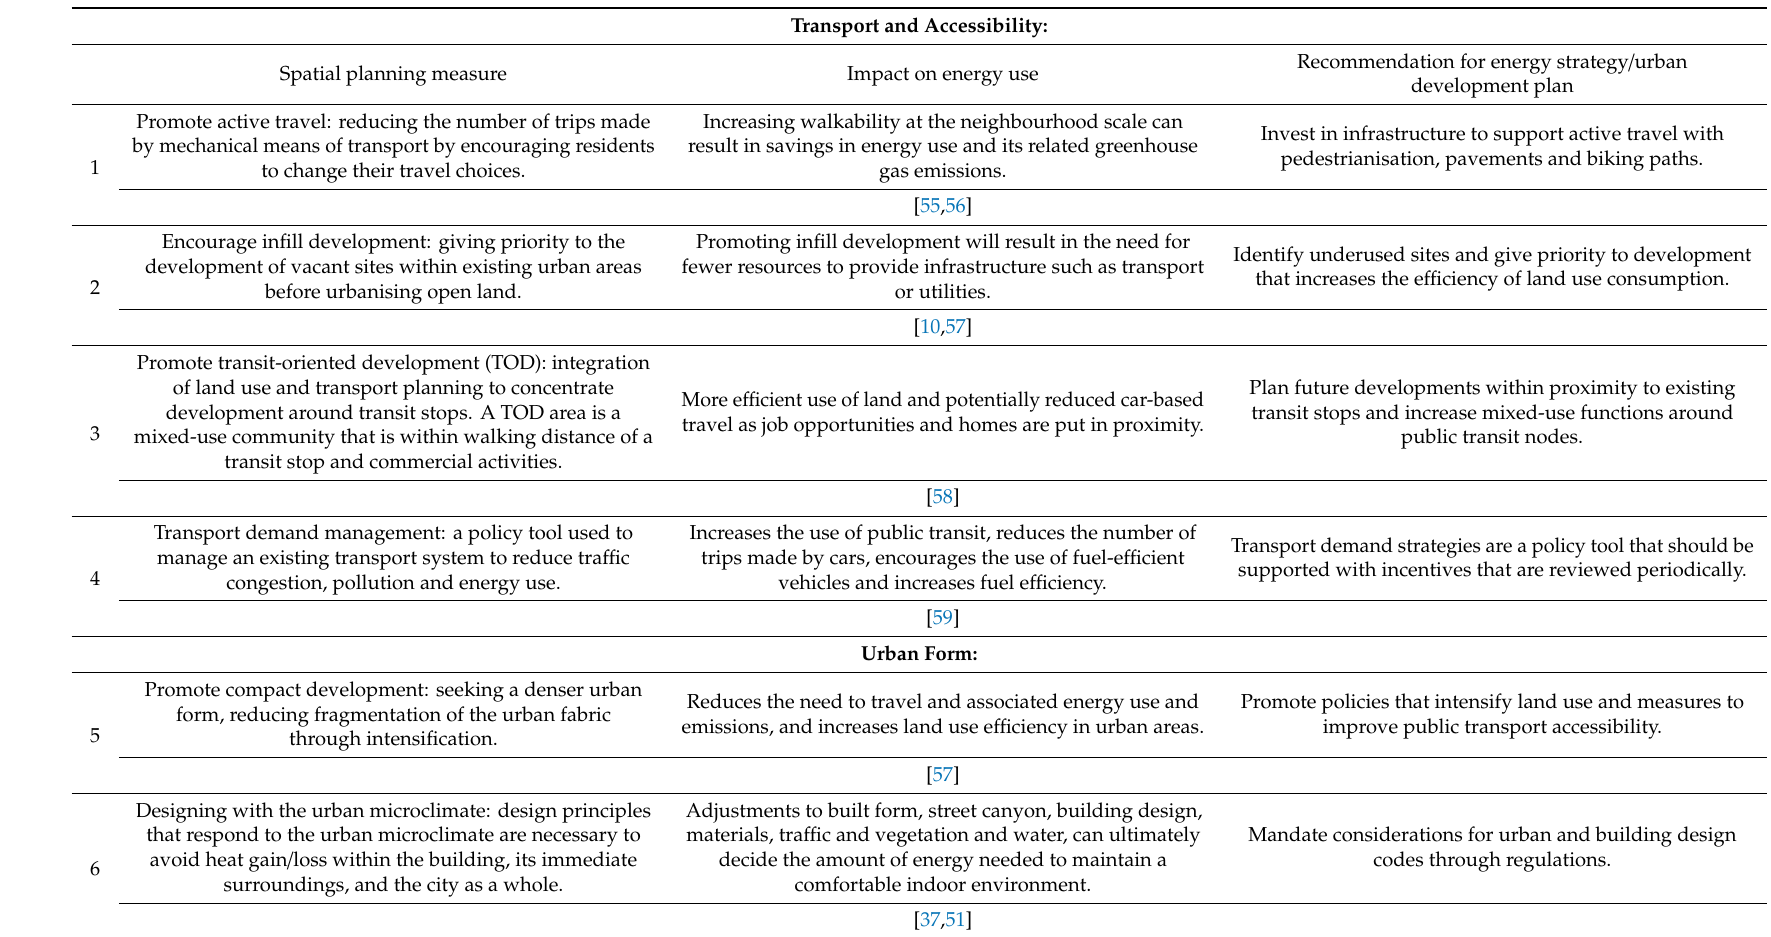
Table 1. Measures in the urban dimension for the energy